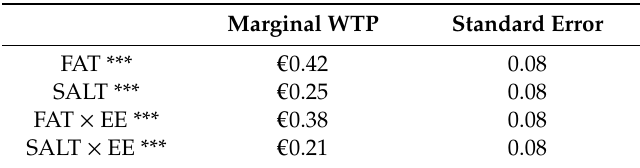
Table 4. Marginal willingness to pay (WTP) for toasted bread with reduced-fat and low-salt content